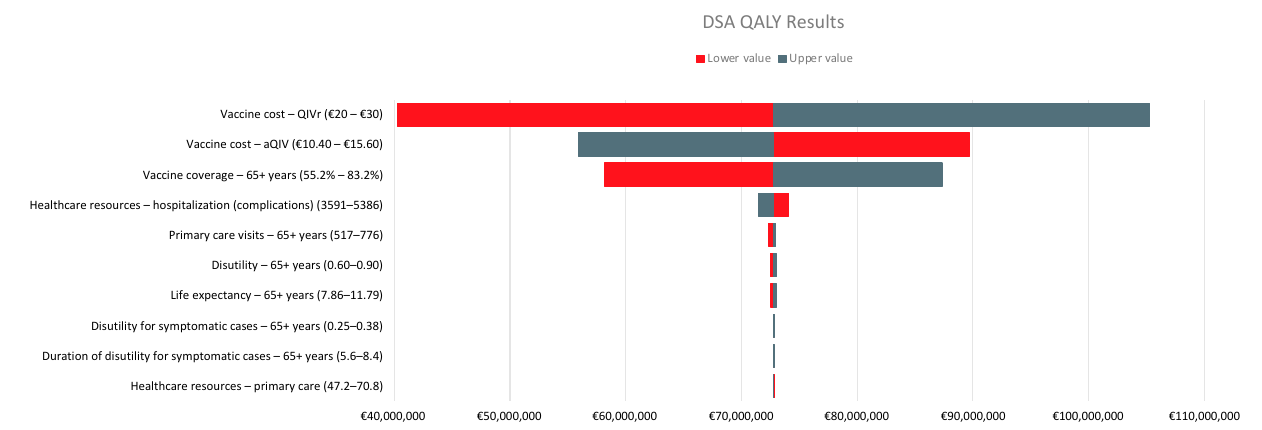
Figure 2. Tornado diagram showing the incremental net monetary benefit for recombinant quadri- valent influenza vaccine (QIVr) vs. adjuvanted quadrivalent influenza vaccine (aQIV) at a willing- ness-to-pay threshold of EUR 25,000 per quality-adjusted life year (QALY).